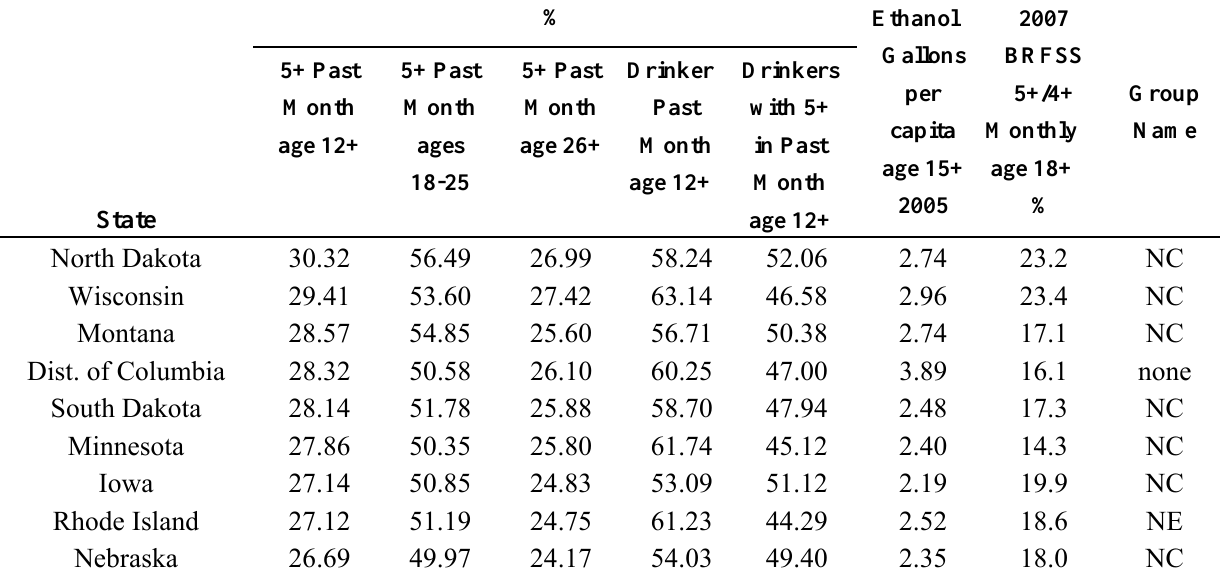
Table 1. States ranked by percentage of population 12+ who reported any 5+ in the past month in the 2005-6 NSDUH with additional age categories for past month 5+, percentage of drinkers and percentage of those with 5+ days among drinkers in the past month, per capita apparent alcohol consumption for 2005 and % reporting 5+/4+ in the past month in the 2007